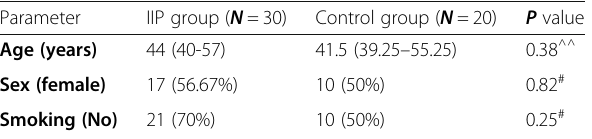
Table 2 The clinical characteristics and ABG S of the patients' Table 1 The demographic characteristic of the study